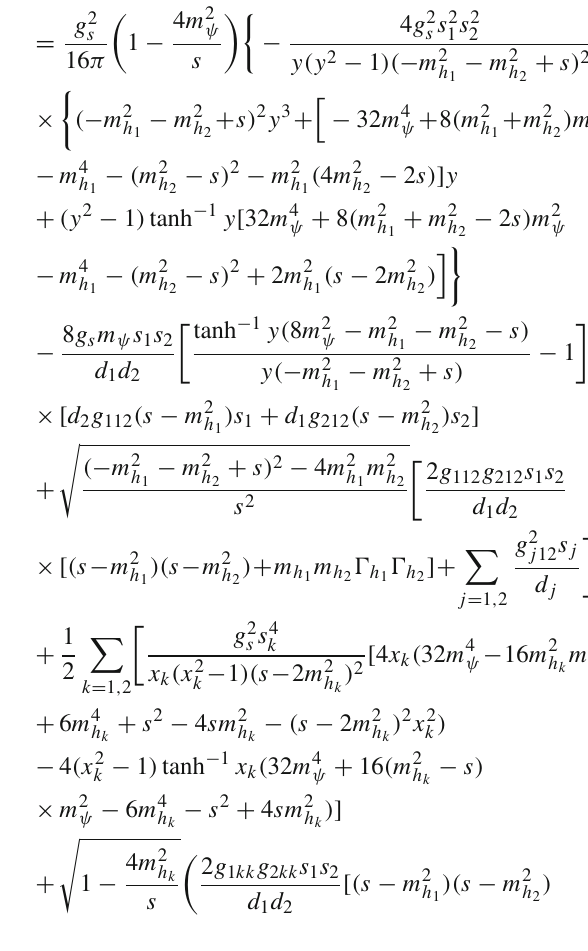
final state only the dominant Feynman diagrams are shown. Obviously, the first row is due to the s -channel, while the second row indicates the t - and u -channels